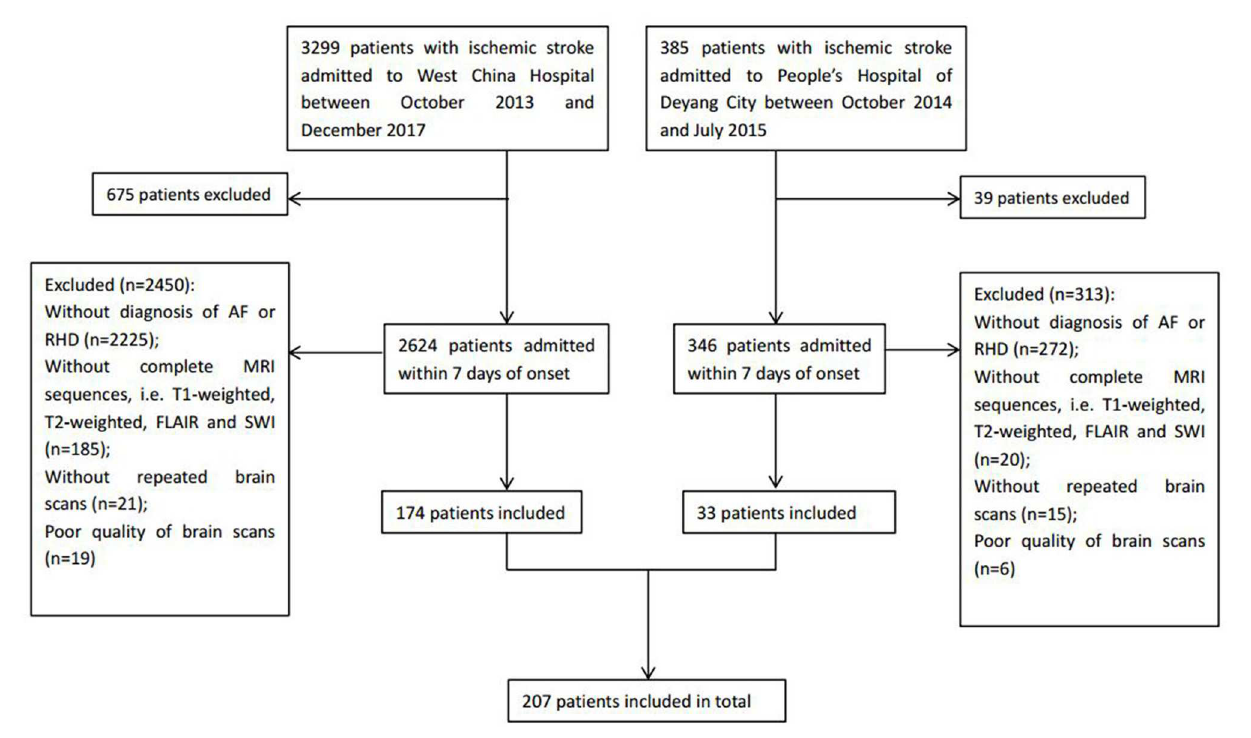
FIGURE 1 | Flowchart of patient